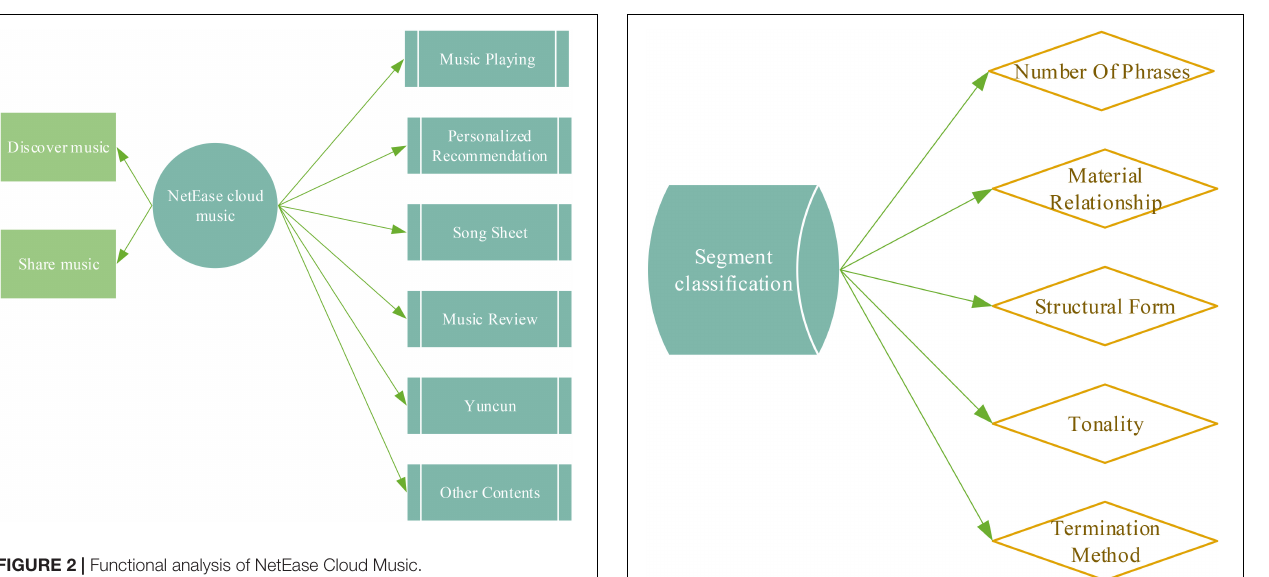
FIGURE 2 | Functional analysis of NetEase Cloud Music.